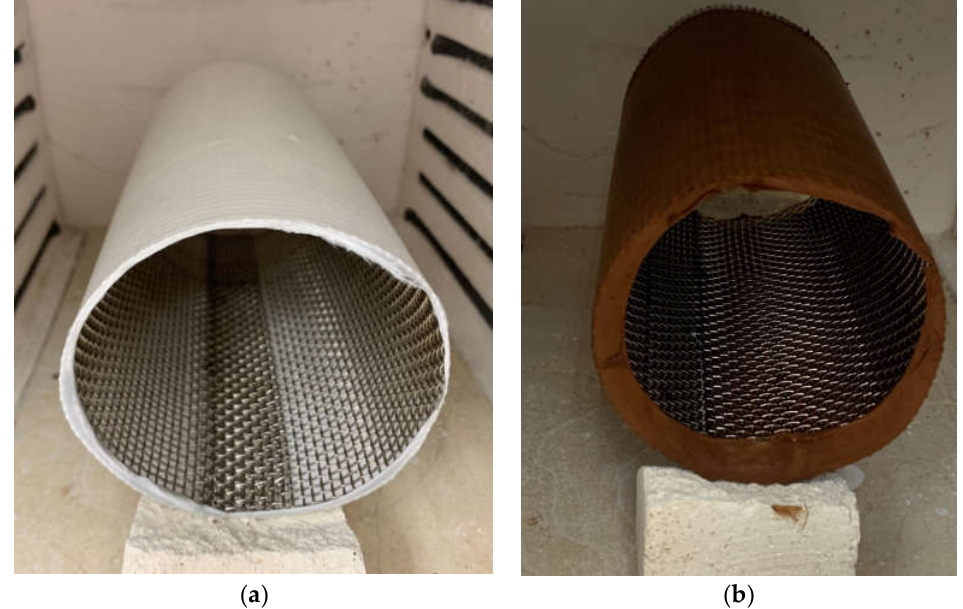
Figure 8. Stabilization of cylindrical media for trial. ( a ) As-spun polyacrylonitrile fiber media for trial #5. ( b ) Stabilized polyacrylonitrile media for trial #4.